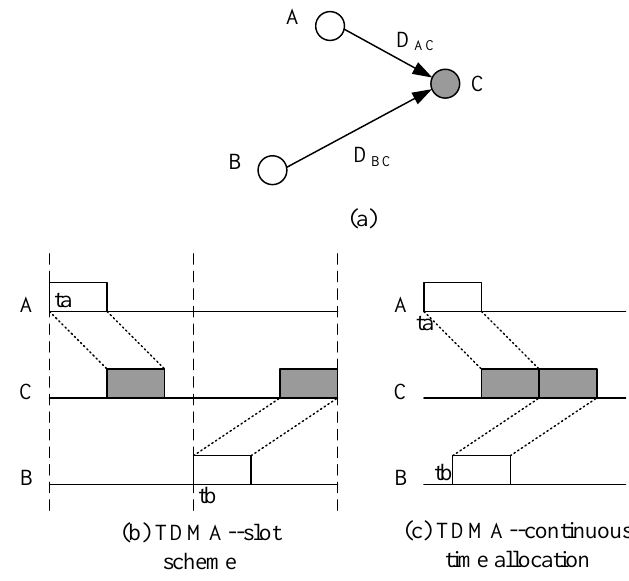
Figure 1. Different UWSN transmission moment